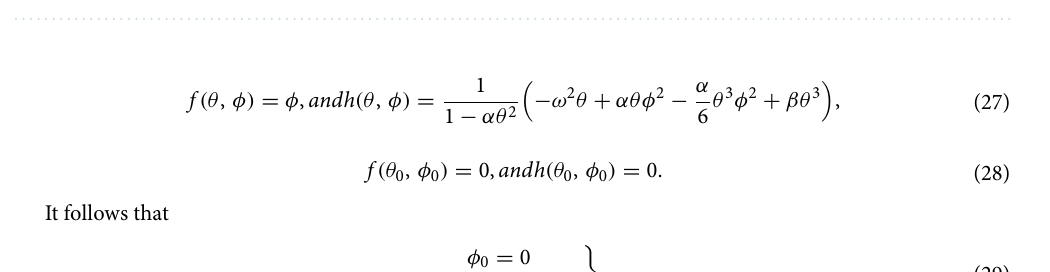
Table 1. Represents the equilibrium points.